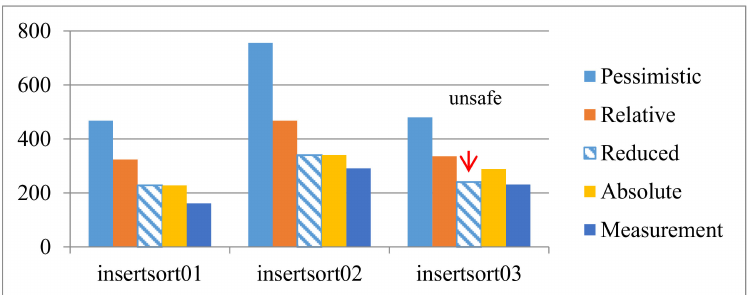
Figure 3. WCET estimations obtained by using different